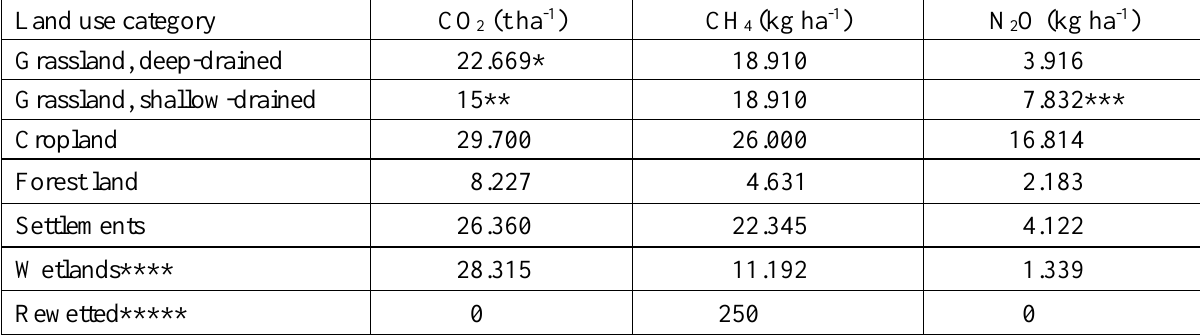
Table A1. Implied CO 2 , CH 4 and N 2 O emission factors used in this study (after UBA 2019). Land use category